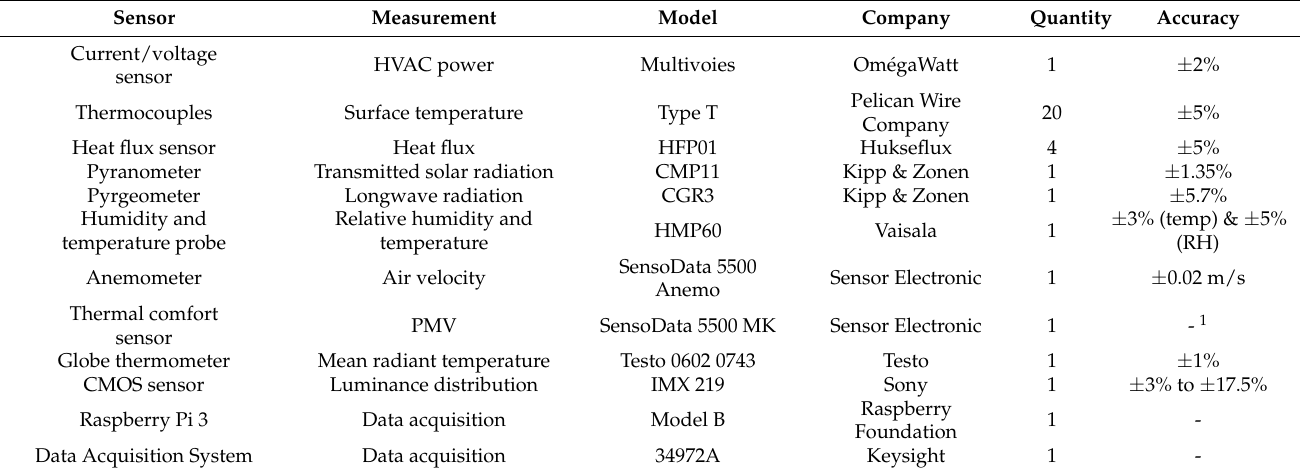
Table 5. List of sensors for each room.